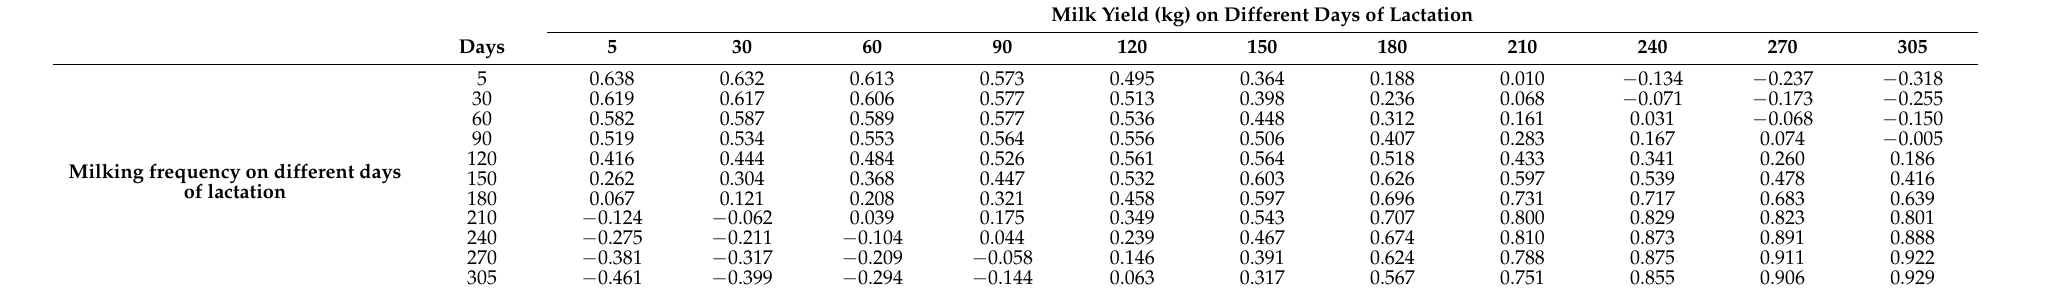
Table 7. Genetic correlations between milking frequency and milk yield in different days of lactation.